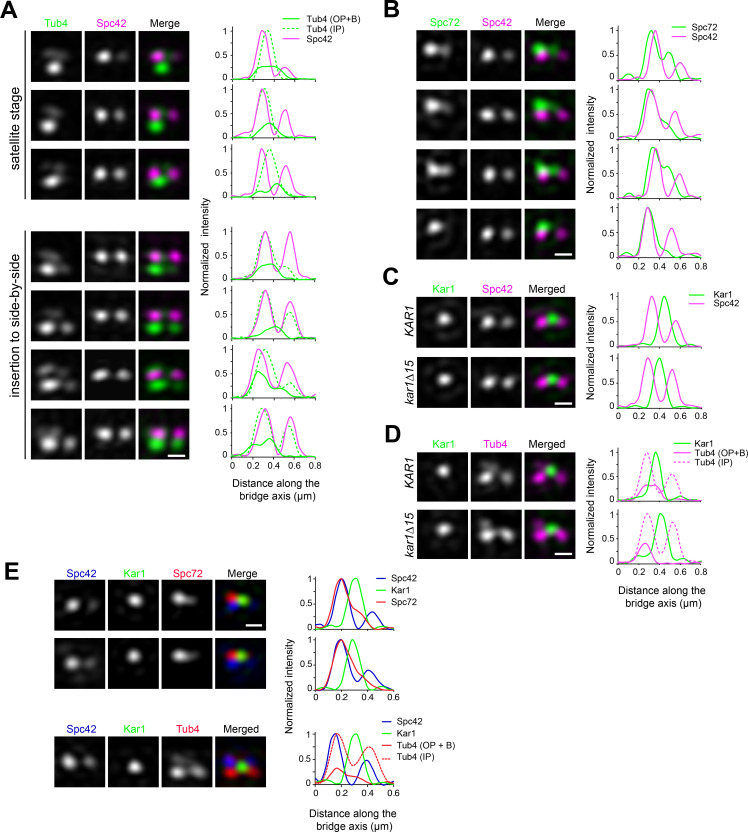
A subset of cytoplasmic nucleation sites coincides with Kar1 localization in unseparated SPBs.(A–C) Comparative localization of Tub4-Venus, Spc72-Venus, Venus-Kar1 or Venus-Kar1∆15 (in green) relative to Spc42-mT2 (magenta). Representative SIM image projections were obtained after 3D-Gaussian fit and realignment using Spc42-mT2 as reference. The corresponding linescan for fluorescence intensity along the bridge axis is also shown. When indicated, separate profiles were obtained along inner and outer plaques (one pixel-width, parallel to the bridge axis). As quantified in Figure 2B–C, Tub4-Venus or Spc72-Venus exhibited dual localization at the cytoplasmic face of duplicated SPBs by distributing between the old SPB outer plaque and the bridge. By contrast, Venus-Kar1 or Venus-kar1∆15 was confined to the space between Spc42-mT2 foci, representing the exclusive localization to the bridge. (D) Partial overlap between Tub4-mT2 (magenta) and Venus-Kar1 (green) signals at the bridge was abolished when cells expressed instead Venus-Kar1∆15. Scale bar, 200 nm. (E) Three color SIM of unseparated SPBs containing YFP-Kar1 (green), Spc42-mCherry (blue) and Spc72-mT2 or Tub4-mT2 (red). Linescan analysis was carried out along inner and outer plaques (one pixel-width, parallel to the bridge axis). Scale bar, 200 nm.